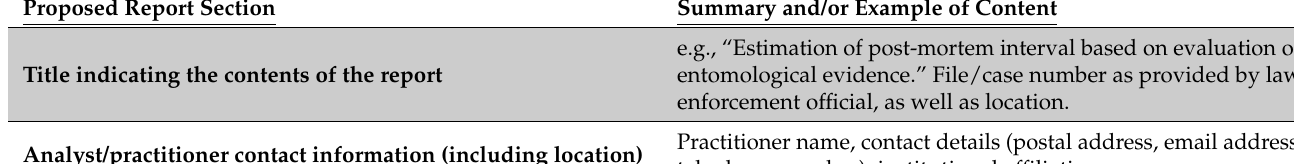
Table 1. Proposed template for a forensic entomological report, with summary of content. Proposed Report